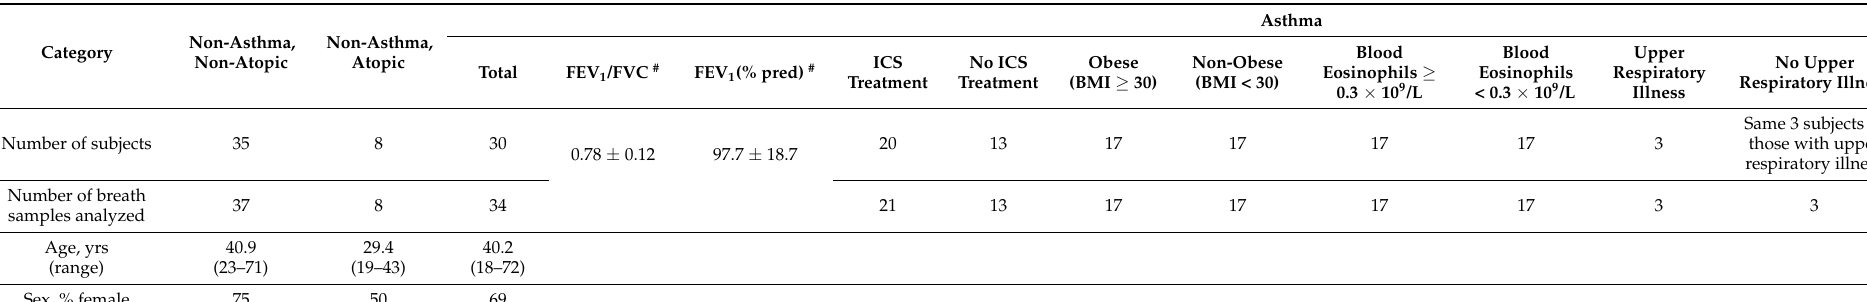
Table 1. Summary of recruited subjects, the total number of breath samples collected and number available for each clinical characteristic analyzed. # post-albuterol, mean ±